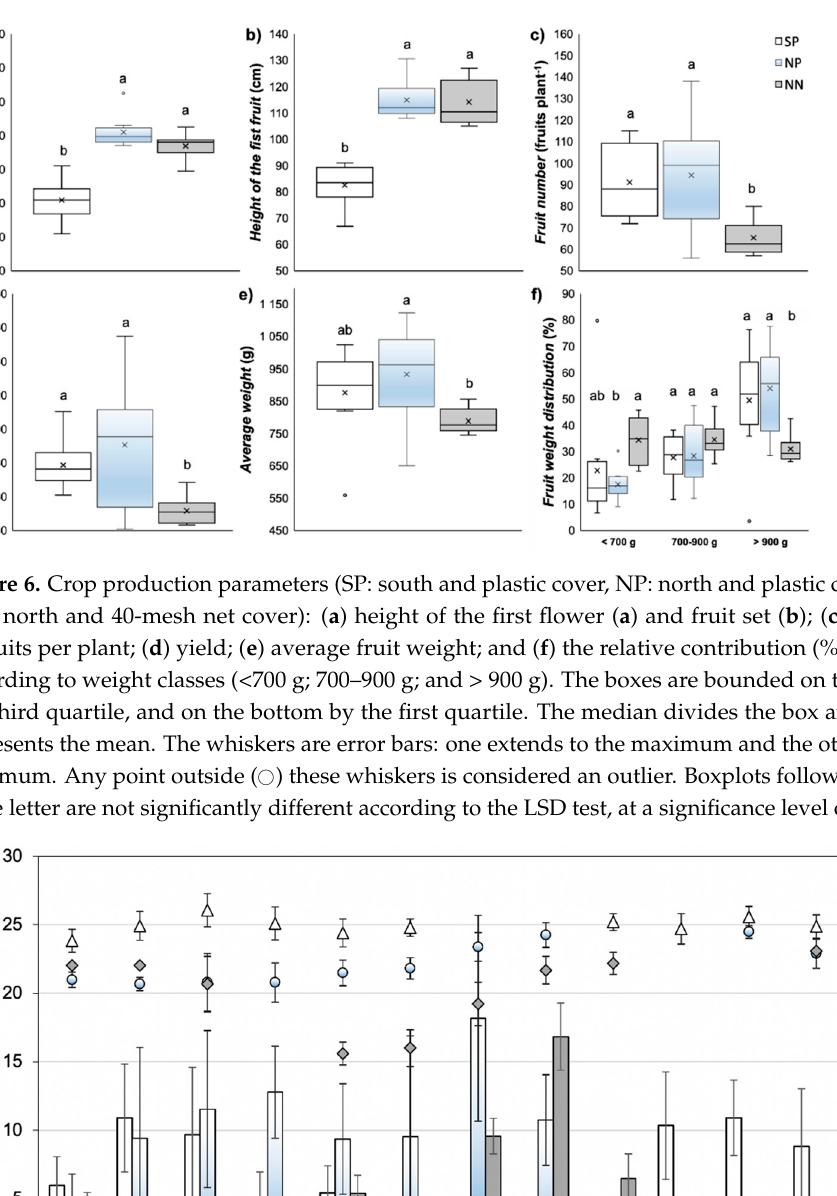
Figure 7. Monthly average yield (kg plant − 1 ) and total soluble solids content (°Brix) in the green-